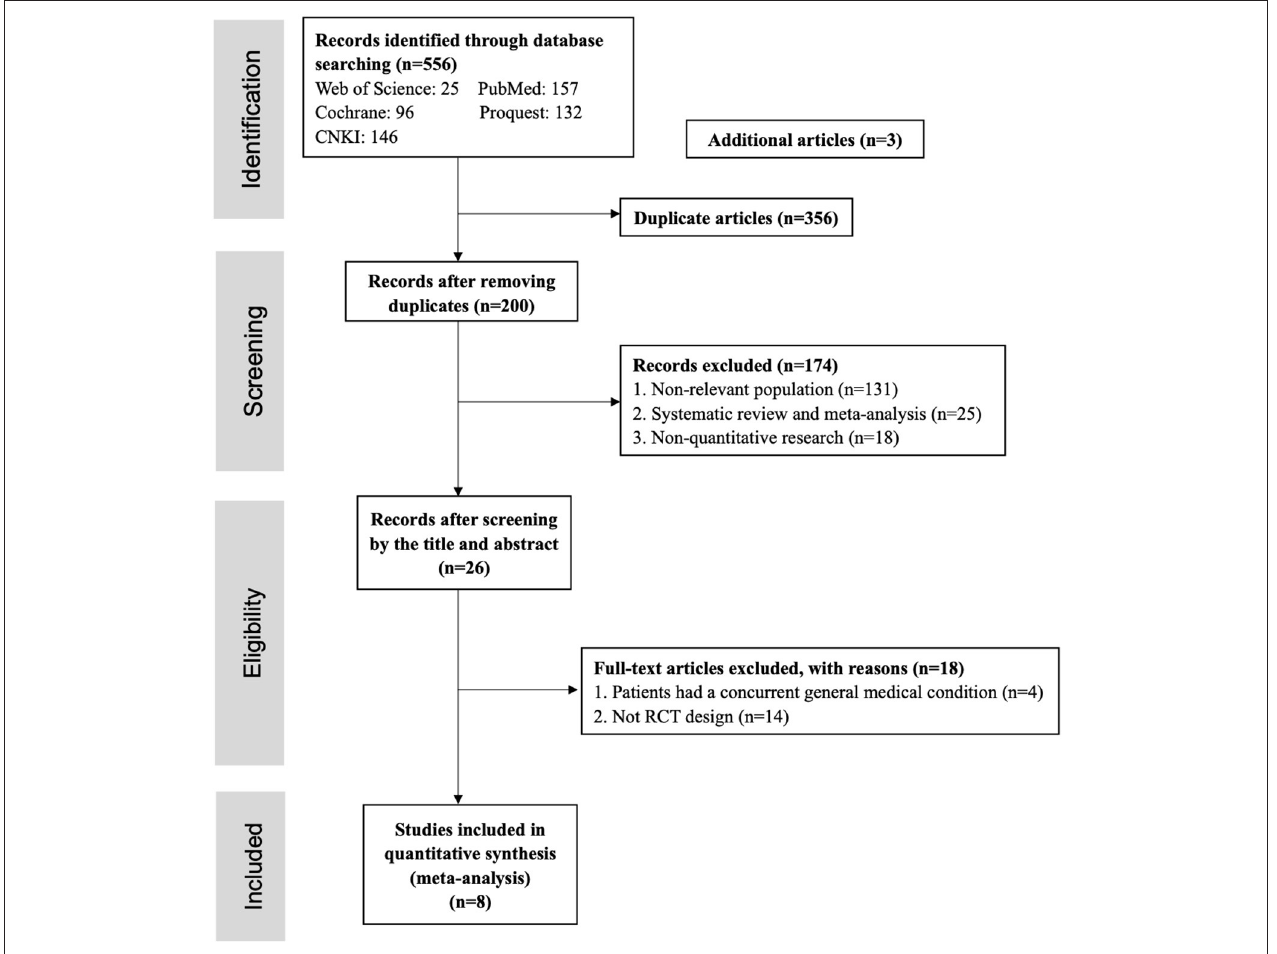
FIGURE 1 | PRISMA flow